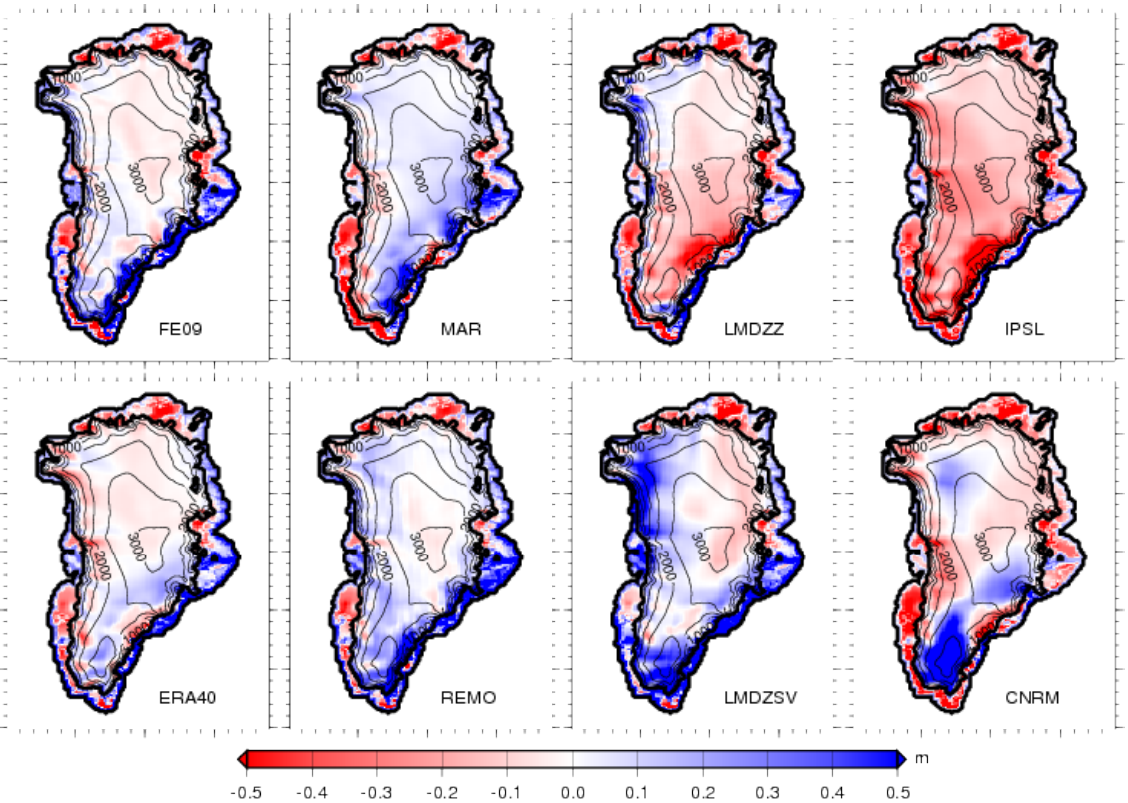
Fig. 8. Difference in annual accumulation between ISM evaluation (after downscaling, snow and rain partitioning and refreezing) and observation based map (Burgess et al., 2010; van der Veen et al., 2001) for each individual atmospheric forcing. Table 3. Large scale biases of atmospheric forcing fields with respect to FE09 and key variable explaining the deviation of volume (bold). Atmospheric forcing Anomaly in temperature and Anomaly in temperature field precipitation South and precipitation North ERA40 Warm Warm MAR Warm and dry Cold and wet REMO Warm and wet Warm and wet LMDZZ Dry Warm LMDZSV Warm and wet Warm and wet IPSL Cold and dry Cold and dry CNRM Very warm and wet Very cold and